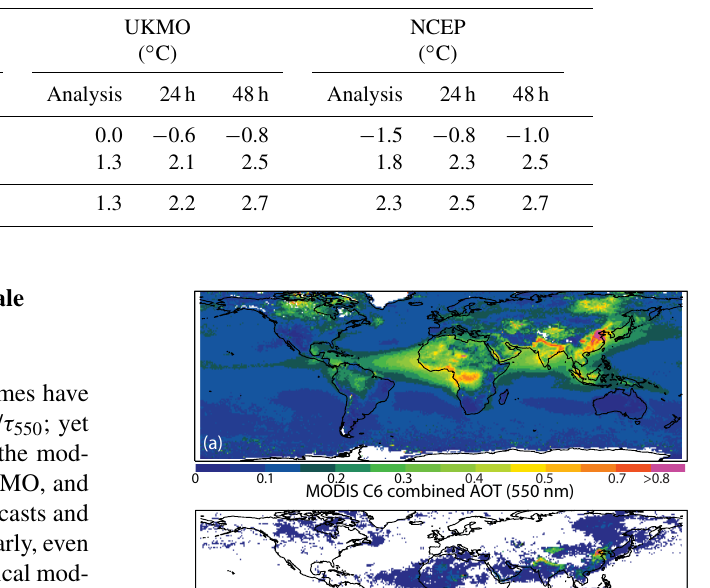
Table 6. The means and 1 standard deviations (1 SD) of the differences in observed and modeled near-surface air temperatures ( T ground-FC ) for 0-, 24-, and 48h (0, 30, and 54h for ECMWF) forecasts for NCEP, UKMO, and ECMWF model runs over the upper Midwest region. The modeled data are compared with surface temperature measurements from ground stations as shown in Fig. 3g for the period of 15 June– 14 July 2015 (excluding 29 June 2015 data).